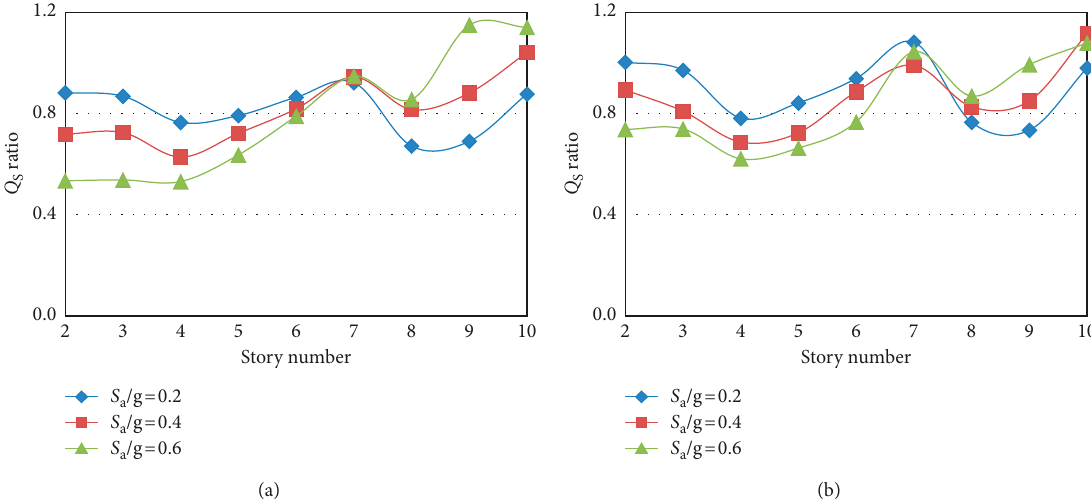
S a /g=0.2 S a /g=0.4